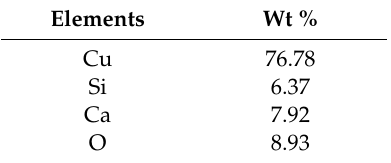
Table 1. Content of the impurities on graphene by EDS analysis.